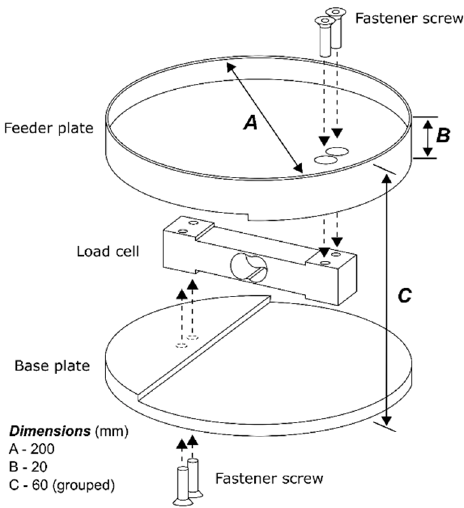
Figure 1. Schematic of the smart feeding unit prototype